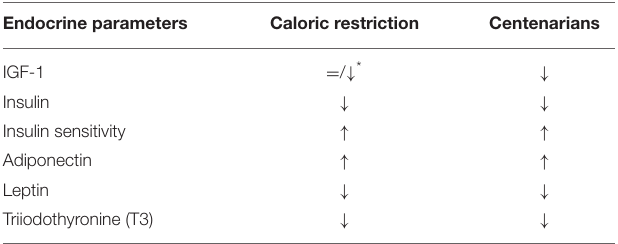
TABLE 1 | Endocrine biochemical profile observed after caloric restriction and in centenarians compared to younger